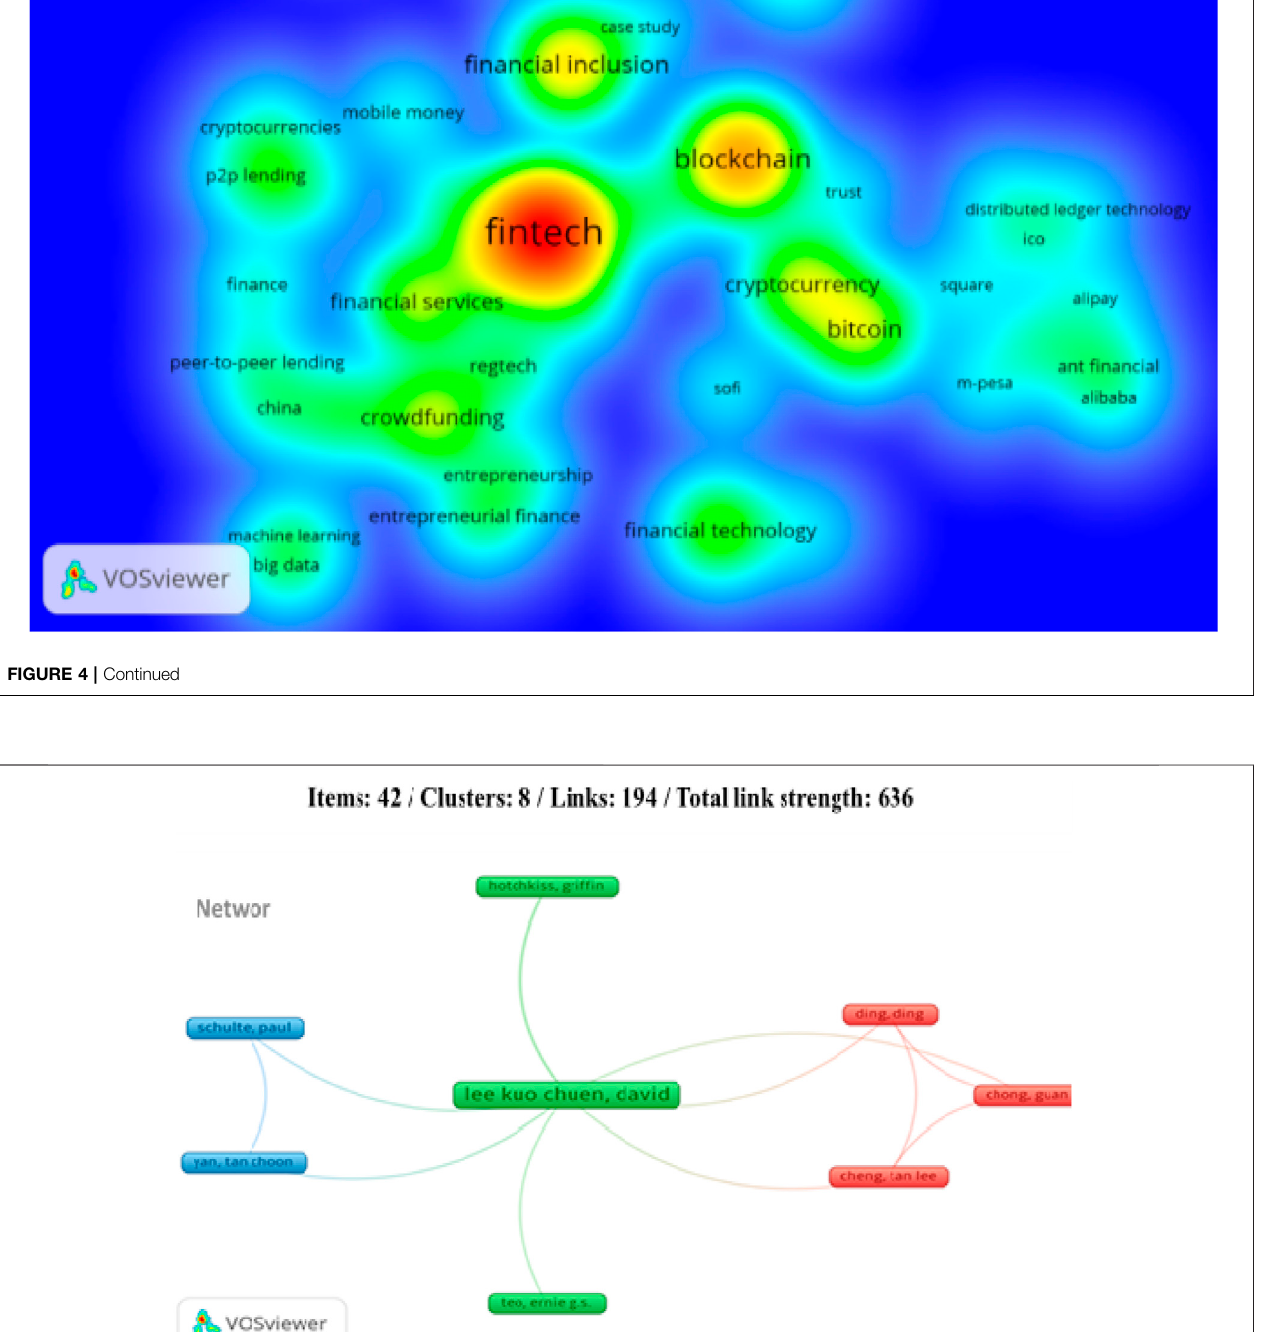
Frontiers in Environmental Science |